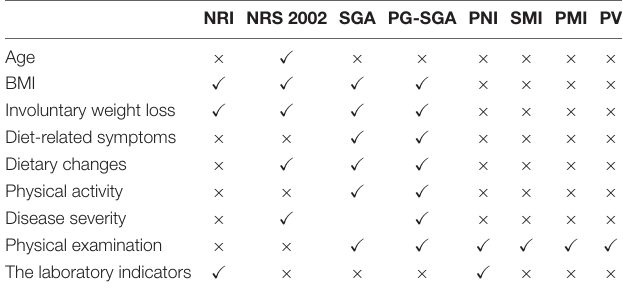
TABLE 1 | Comparison of commonly used nutritional indicators for cancer